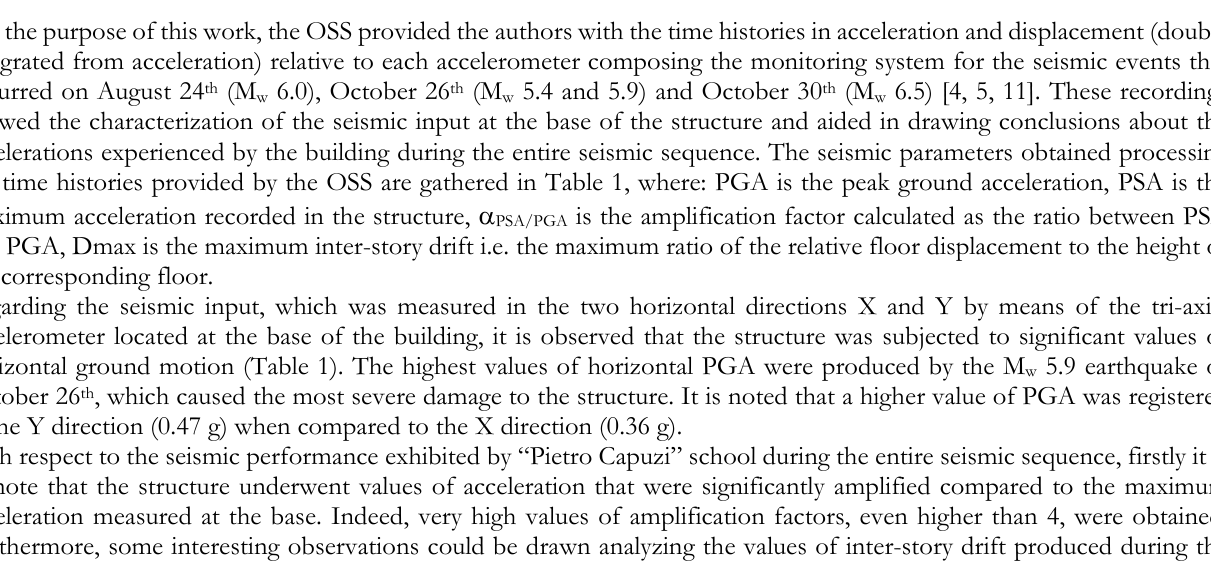
Figure 7: Mode shapes of the first three modes obtained from dynamic identification tests: a) raised ground floor, b) first